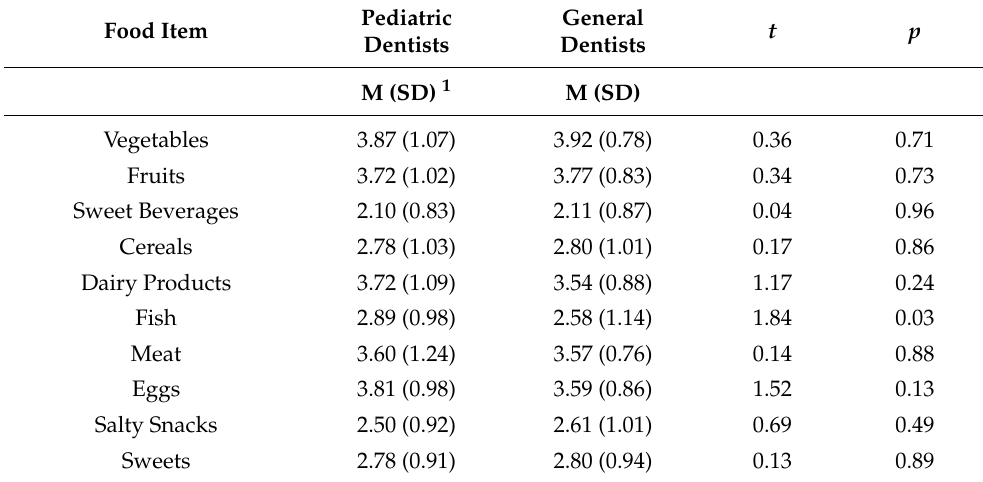
Table 3. Comparison of nutrition habits between paediatric and general dentists’ children. Food Item